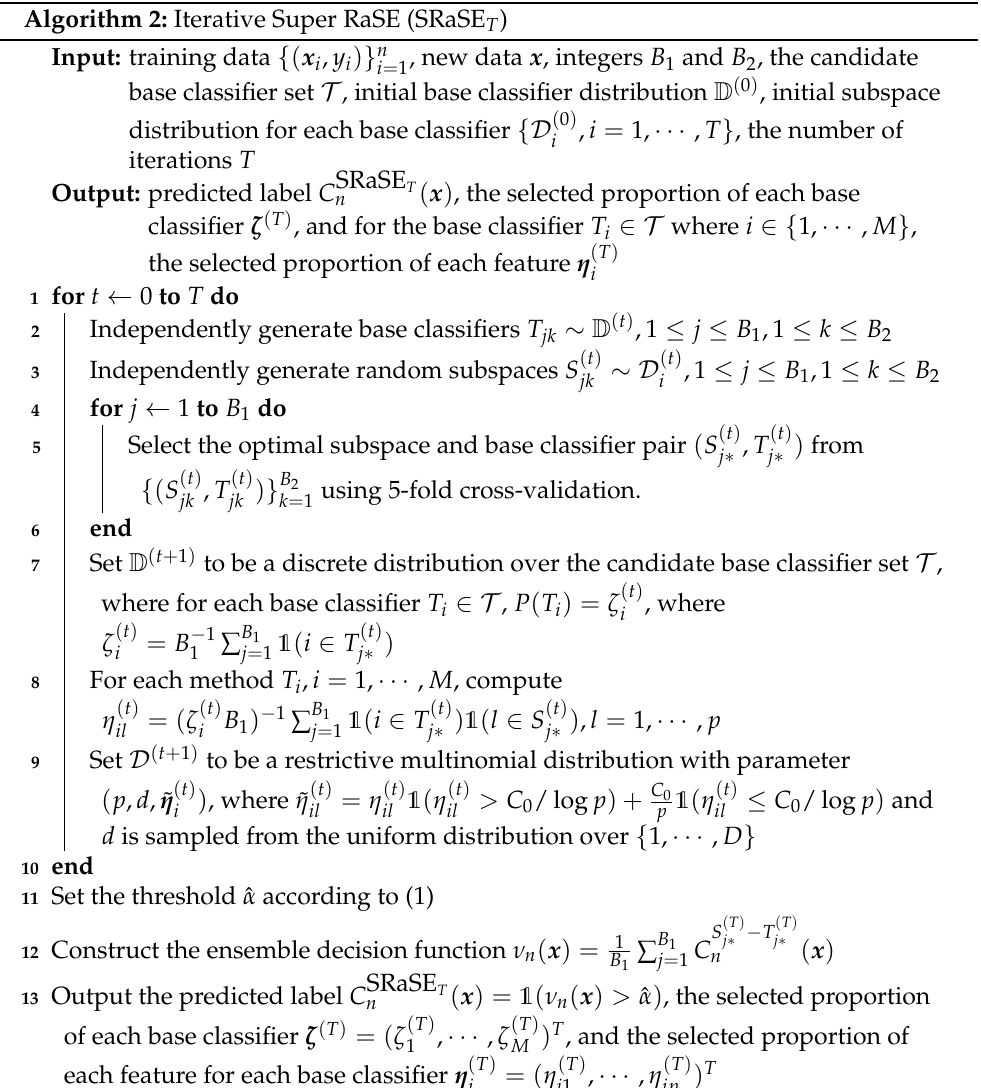
Algorithm 2: Iterative Super RaSE (SRaSE T